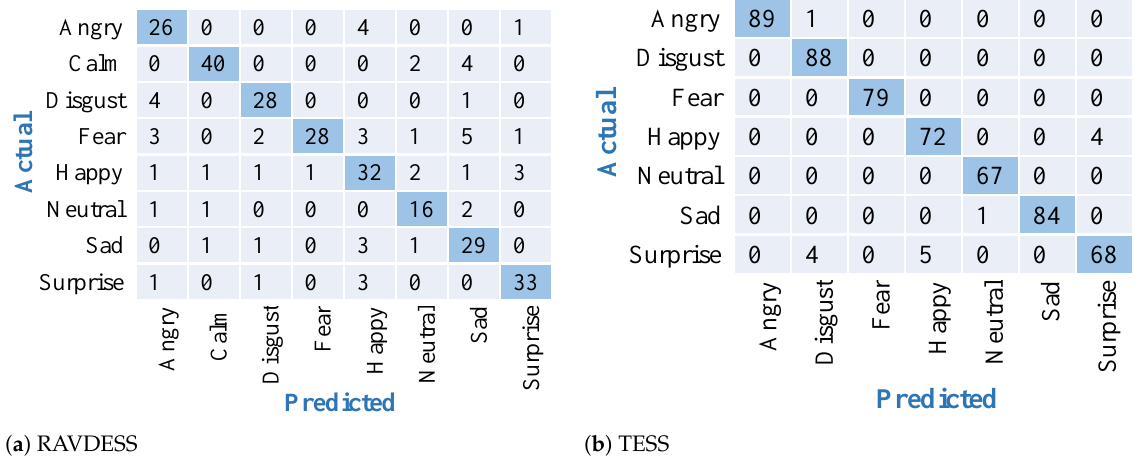
Figure 5. Confusion matrices for feature extraction and modeling using VGG16 over 2 datasets. Diagonal elements with dark blue color show accurately predicted